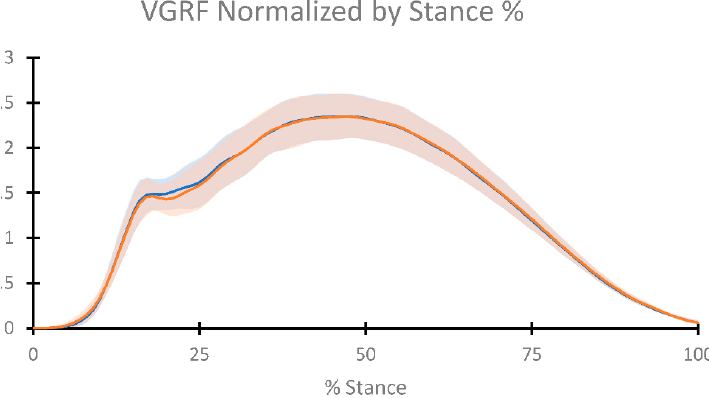
Figure 1. Mean VGRF in the dominant leg (BW) normalized by time comparing male and female shoe conditions. The female shoe is represented in blue (C1), and the male shoe is represented in orange (C2). When comparing sagittal plane joint angles in the ankle, knee, and hip normalized over stance, there appeared to be no significant difference between shoe conditions as seen in Figure 2.